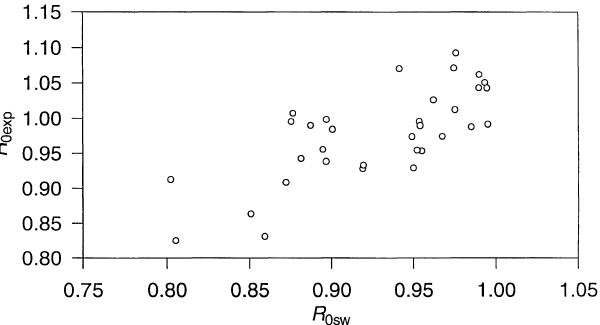
Fig. 8. Scatter plot of normalized values of the experimental magnetopause stand-o(cid:128) distances versus theoretical ones with B mth calculated from solar wind parameters